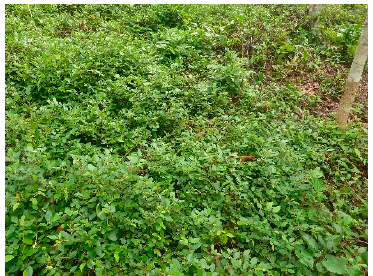
Figure 21. Desmodium ovalifolium .